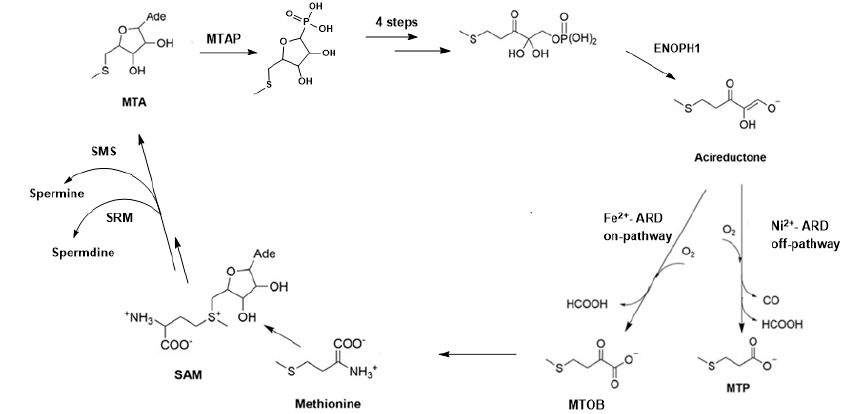
Figure 2. The methionine salvage pathway.